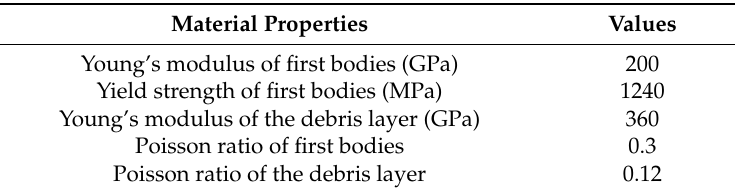
Table 1. Material properties used in finite element (FE) models.